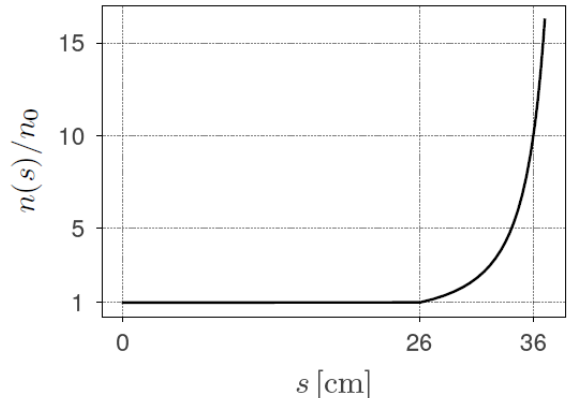
Figure 6. A tailored plasma density profile designed to eliminate the re-acceleration of particles in the bunch tail in the EuPRAXIA 5 GeV beam. The plasma density exhibits uniform behaviour until s = 26 cm, followed by a non-linear growth that reaches a 15-fold higher density at s = 36 cm, compared to the former uniform plasma density.